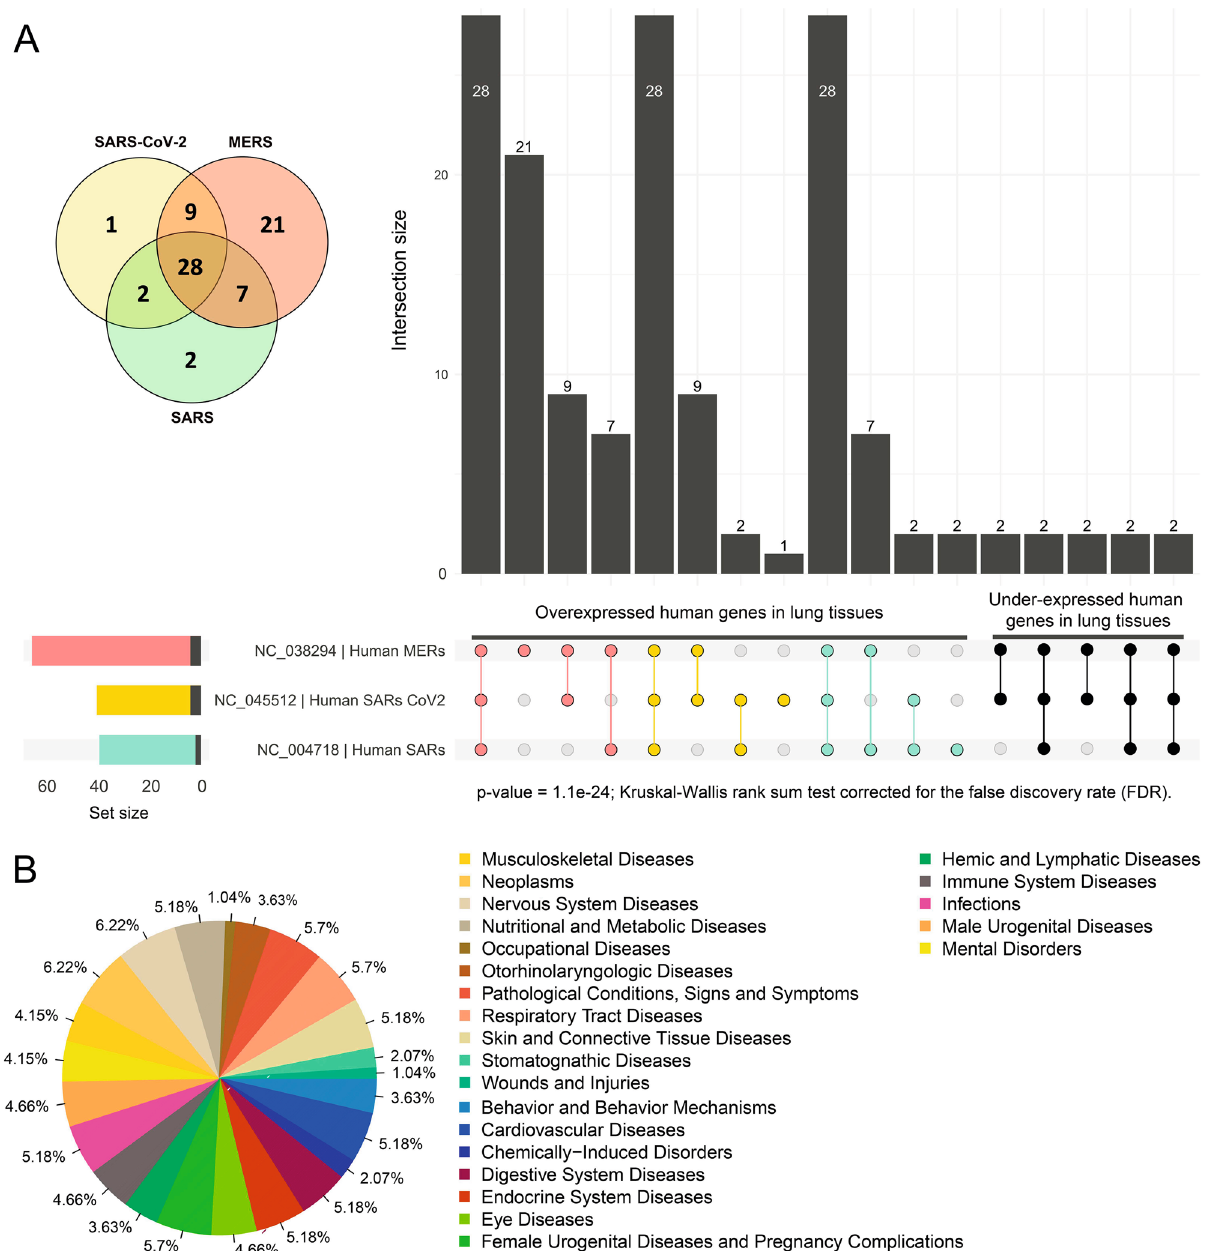
Figure 4. ( A ) Venn diagram and UpSet plot representing the number of overexpressed and under-expressed human genes in lung tissues that clustered together with viral genes for SARS-CoV-2 (NC_045512), SARS (NC_004718) and MERS (NC_038294) based on the molecular features. ( B ) Diseases frequencies associated to human genes grouped with viral genes of SARS-CoV-2, SARS and MERS in the clustering analysis. The differences observed among the groups and gene counts showed to be significant according to the chi-square test that showed a p-value of 1.1e −24 (Kruskal–Wallis rank sum test) and corrected for the false discovery rate